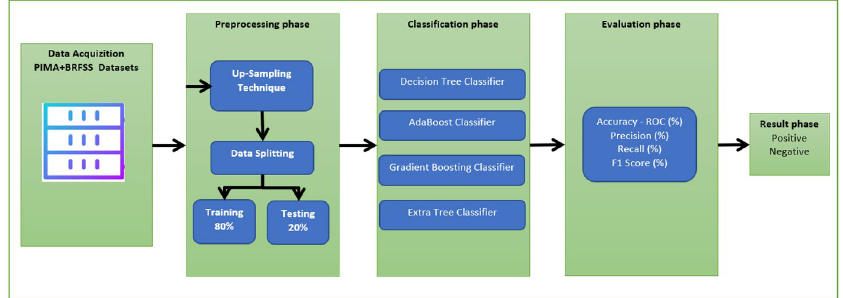
Fig. 1 The proposed framework for diabetes classification using machine learning